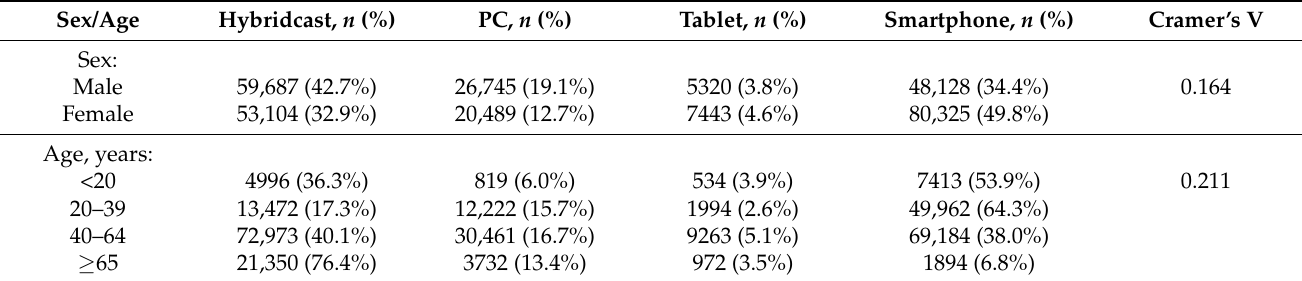
Table 4. Types of Internet device used to answer the questionnaire